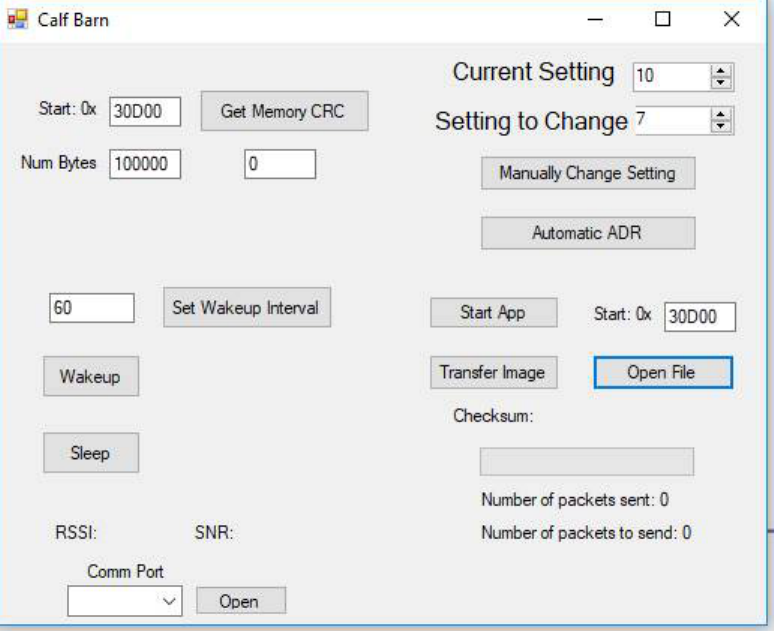
Figure 11. The PC interface to control the firmware